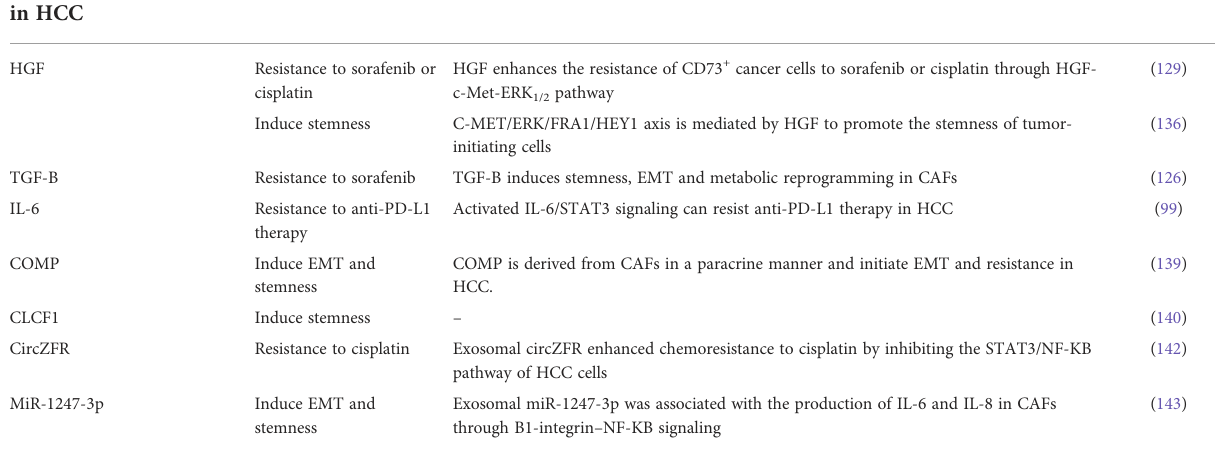
TABLE 2 CAFs-derived molecules promote chemotherapy resistance in HCC. CAFs-derived molecules in